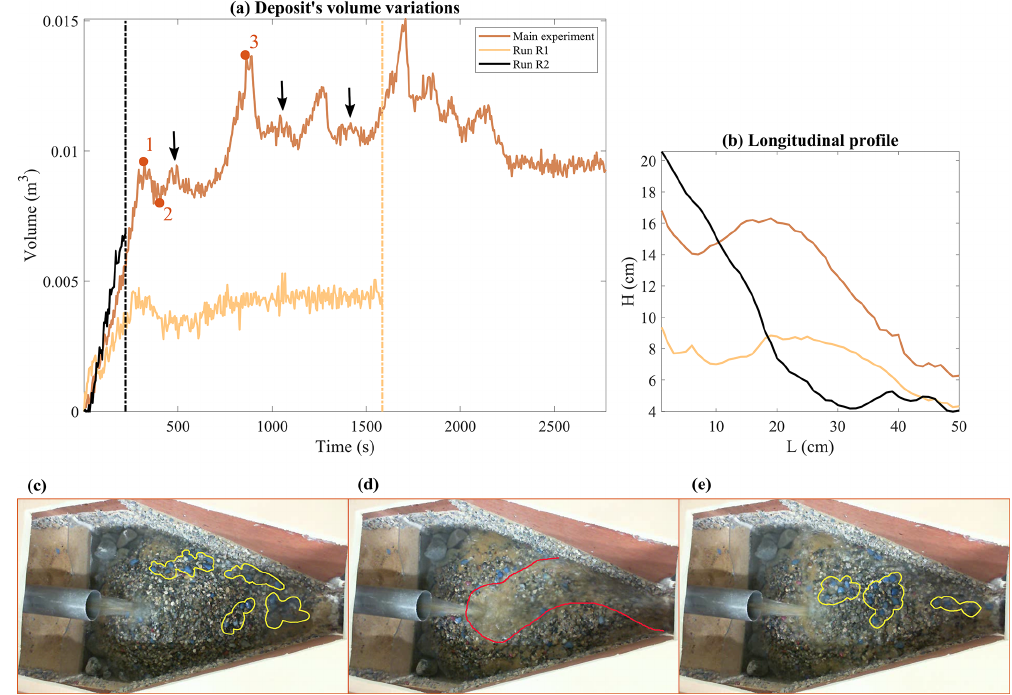
Figure 5. (a) Results from the Kinect camera for the three runs. The volume variation of the deposit is shown versus time. The two vertical dotted lines show the end of the runs with the uniform mixtures. The black arrows indicate the sediment releases occurring after the larger destabilizations and before the following aggradation phase described in the text. The orange dots and numbers refer to the images below. The frames of the video recording represent the steps of the cyclic behaviour experienced by the storage area, with the following: (c) the aggradation phase of the deposit and armouring at its maximum; (d) the sediment pulse to the channel following the destabilization of the deposit with sand no longer hidden but exposed to the flow; (e) a new armouring phase. The yellow-bordered particles form the surface armour, while the red-bordered area shows the destabilized mass. (b) Comparison between the longitudinal profiles of the deposit for the three experiments when the aggradation phase is at its maximum. The profile is the result of the intersection between the deposit and a plane normal to the storage area’s base and parallel to the